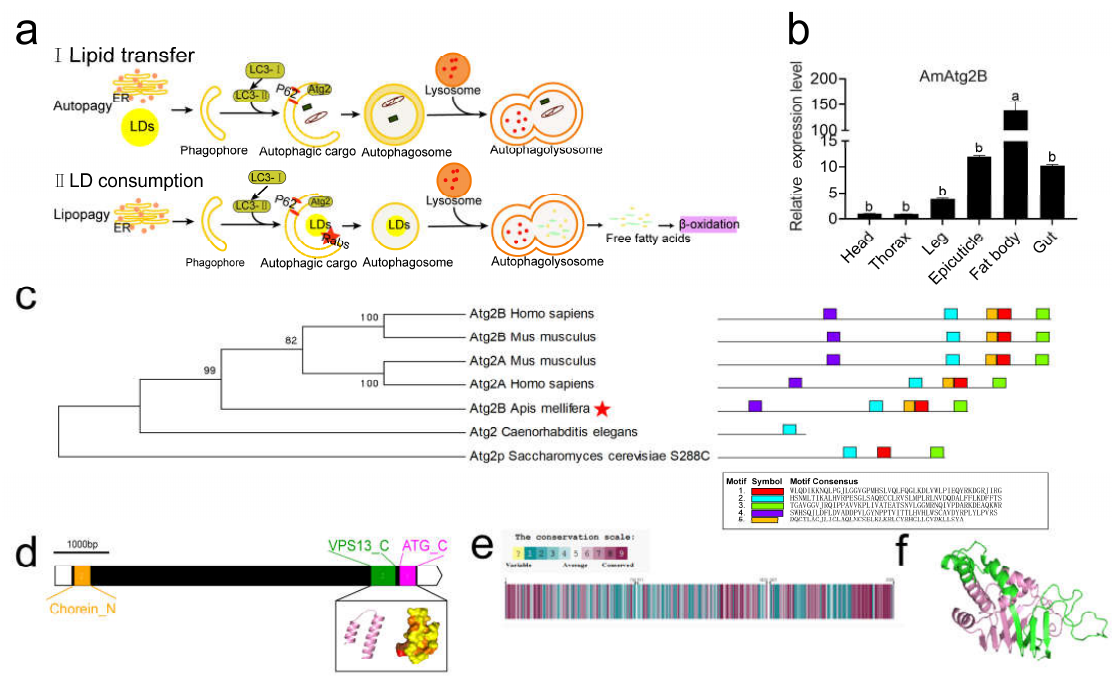
Figure 3. AmAtg2B tissue specificity expression and AmAtg2B protein structure and function analysis. ( a ) The function of AmAtg2B in mammals and yeasts: autophagosome formation. The lipid source of autophagosome membrane may be endoplasmic reticulum (i) or lipid droplets (ii); ( b ) Expression of AmAtg2B in different tissues as detected by qRT-PCR, data are shown as mean ± SEM